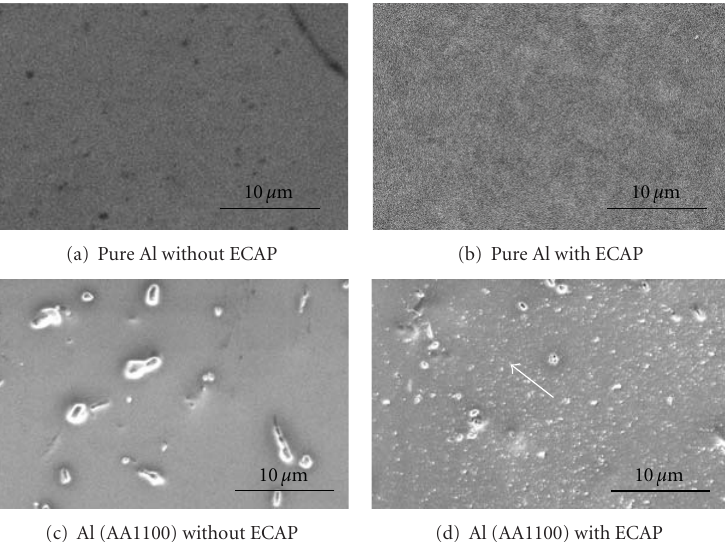
Figure 5: E ff ect of ECAP on the morphology of pure Al and Al (AA1100).